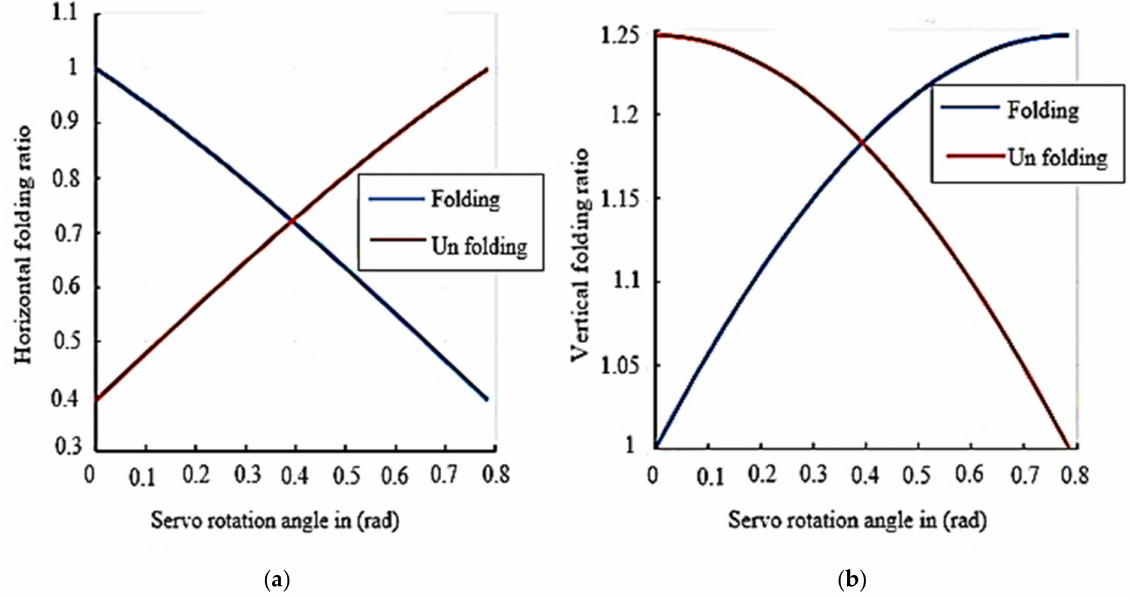
Figure 4. Folding ratio ( a ) Horizontal folding. ( b ) Vertical